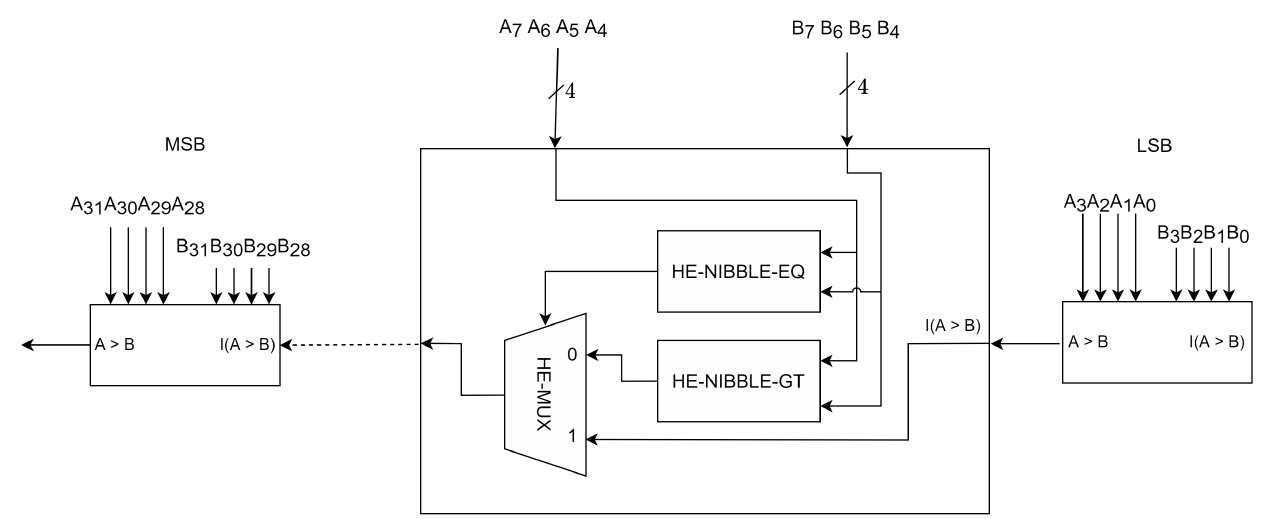
Figure 8. Encrypted 32-bit comparator circuit by cascading 4-bit encrypted